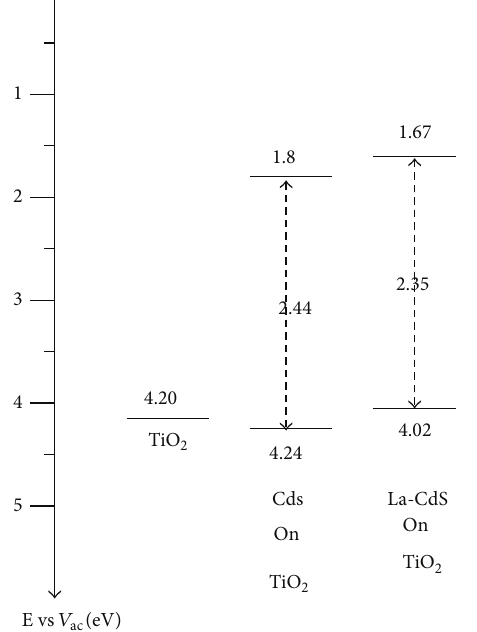
Figure 10: The diagram of La doping to the adjustment of CdS energy level.